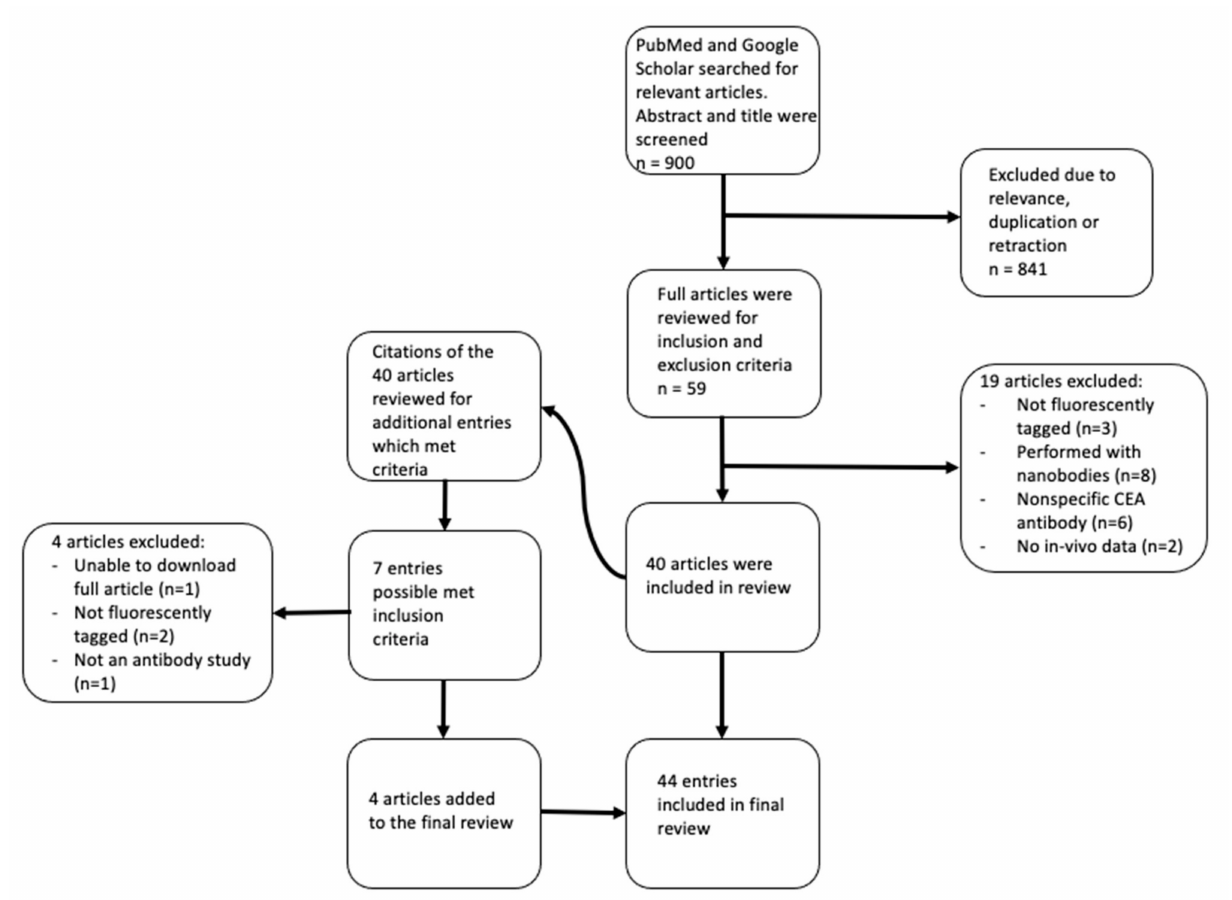
Figure 1. Search criteria and reasons for exclusion of